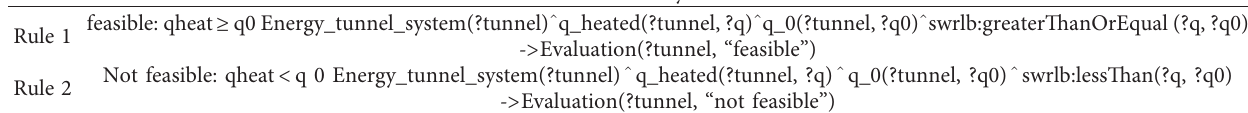
Table 6: The standard of system